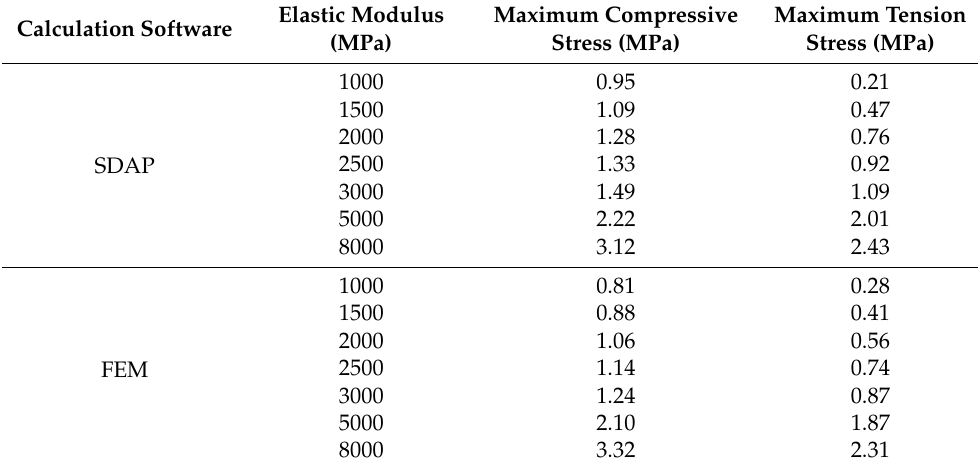
Table 6. Stress and strain calculation results table under different elastic modulus for main dam. Calculation